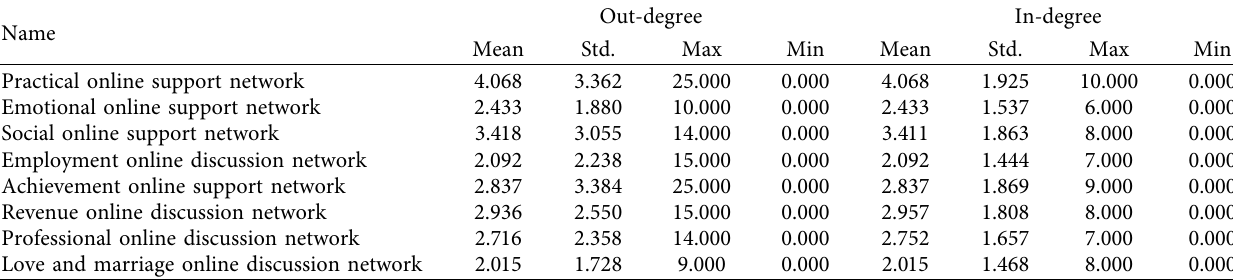
Table 3: Characteristics of the whole online social network structure of athletes.